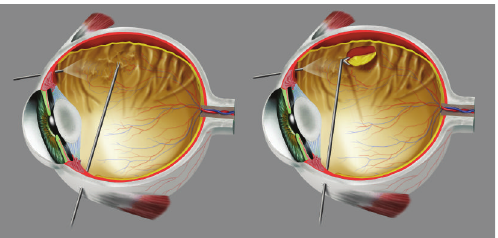
Figure 1: Important surgical steps. Left: peeling of epiretinal membranes using endoillumination and surgical instruments enter- ing the eye through sclerotomies. Right: cut of peripheral retina (retinectomy) allowing further retinal reattachment.